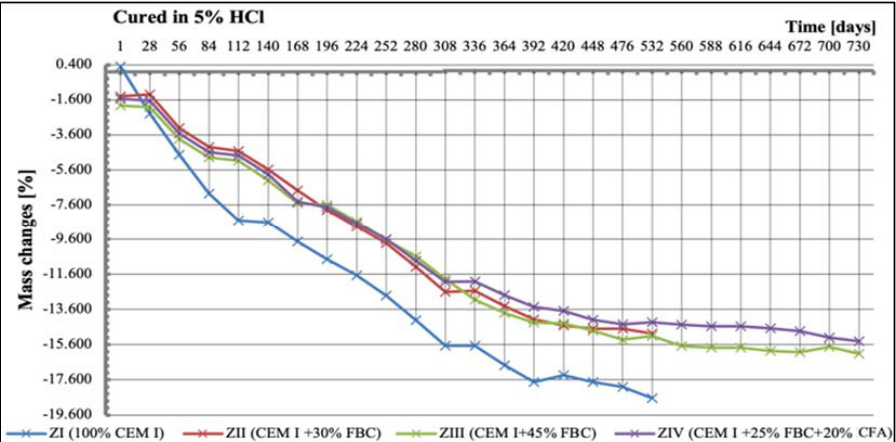
Figure 17. Mass changes of mortars cured in 3% HCl solution for 730 days.